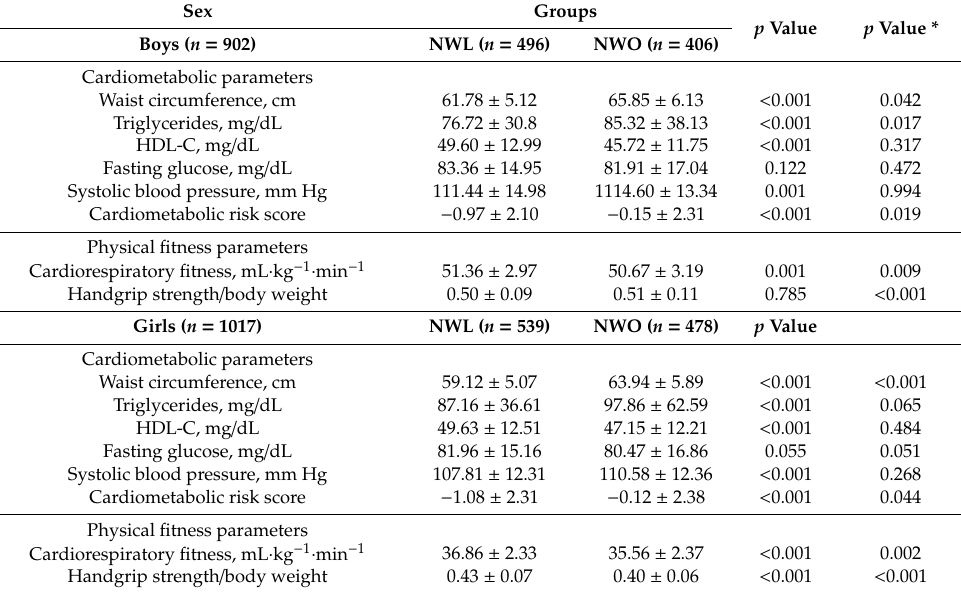
Table 2. Differences in cardiometabolic and physical fitness parameters between normal-weight lean (NWL) and normal-weight obesity (NWO) youth.